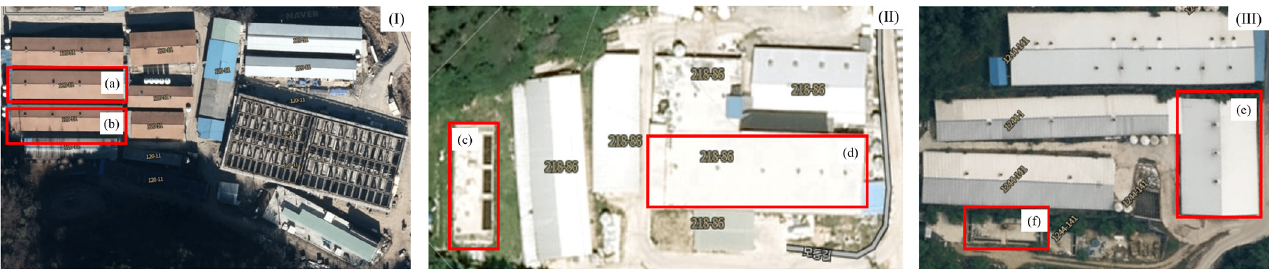
Figure 1. Pictures of experimental farms. (I), common farm not equipped with continuous pit recirculation system (Farm A, control); (II), Farm B; (III), Farm C; (a, b), two rooms of a pig finishing confinement building in a farm not equipped with continuous pit recirculation system; (d, e), two room of a pig finishing confinement building in the farm equipped with continuous pit recirculation system; (c, f), aerated liquid manure manufac - turing